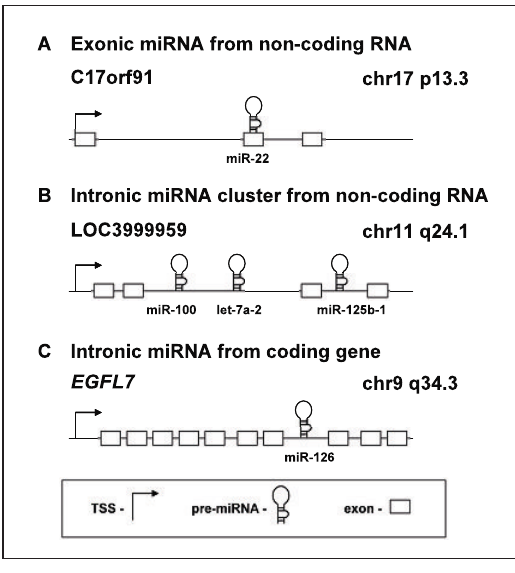
Genomic locations of miRNAs. miRNAs may be located in almost any region of the genome including repeats.They may be grouped into clusters or situated alone, and may be exonic or intronic. A, a miRNA may be part of the exon of a non-coding RNA transcript, such as miR-22. B, polycistronic miRNAs may be grouped into a cluster and transcribed as a pri-miRNA, which yields several miRNAs.This occurs with the miR-100/let-7a-2/miR-125b-1 cluster, which is transcribed as an intron of a non-coding RNA. C, miRNAs may be lo- cated in the introns of canonical genes.The mature miRNA may be processed from the intron of the host gene tran- script.This occurs when miR-126 is processed from the EGFL7 transcript. Arrow, transcription start site; hairpin, pre- miRNA; rectangle,